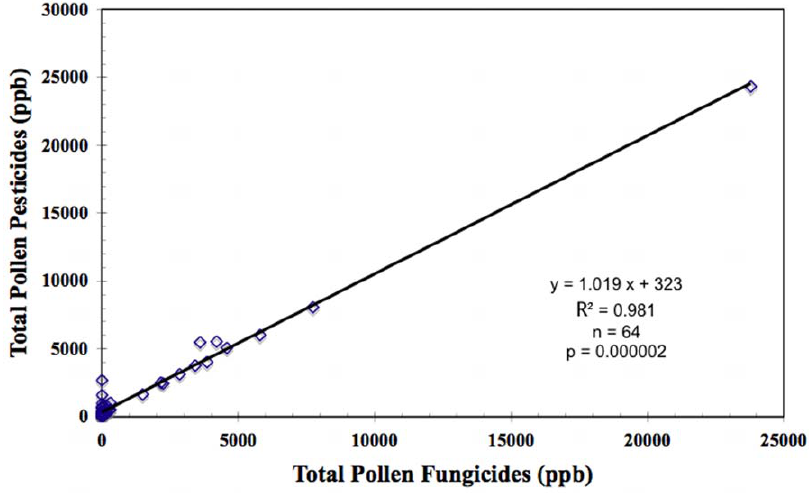
Figure 3. Correlation of total fungicide residues (ppb) with total pesticide contents of pollen samples.